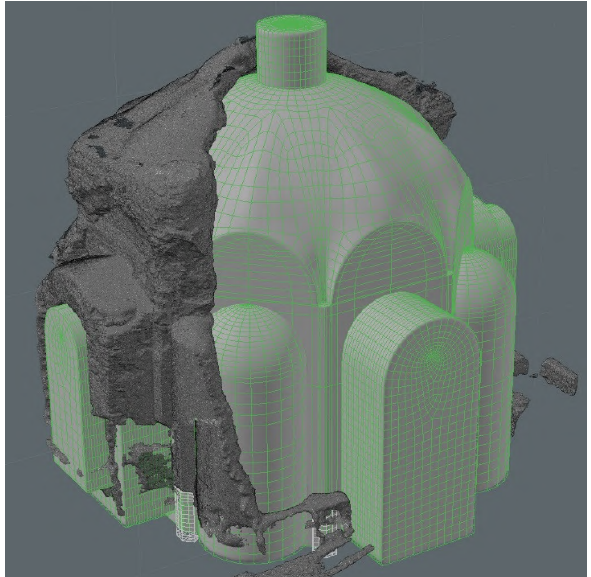
Figure 16. A “compound” of bicubic patches aimed at “carving” the external volumes of the Vestibule.